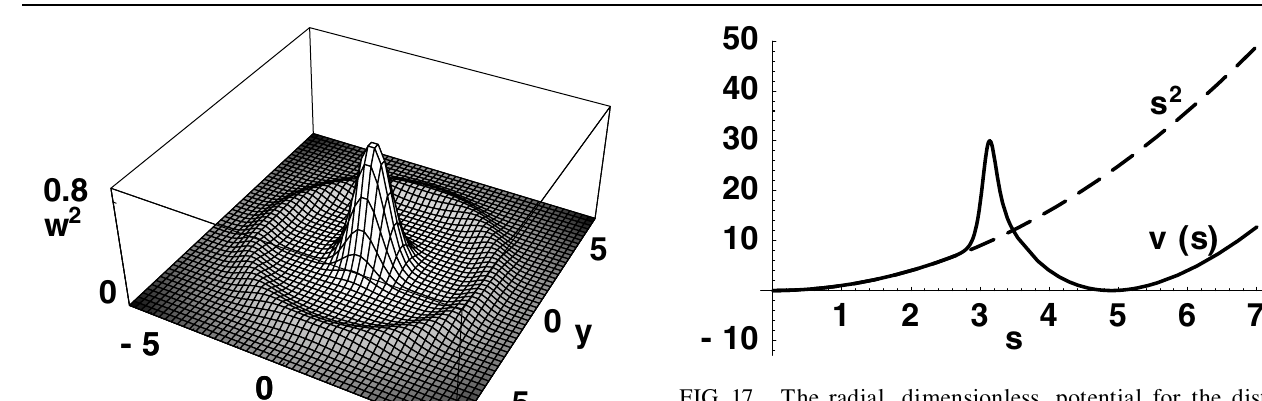
FIG. 17. The radial, dimensionless, potential for the distri- bution of Fig. 15 (solid line), and for a harmonic oscillator (dashed line).